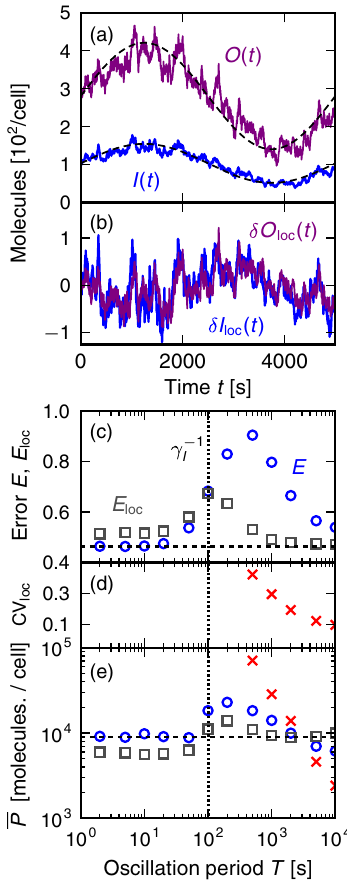
FIG. 5. (a) Sample KMC simulation trajectories for I ð t Þ (solid blue) and O ð t Þ (solid purple) in a Λ ¼ 10 system driven by an oscillatory upstream flux F ð t Þ (see text for parameters). Dashed t Þ and O t Þ . (b) For trajectories in (a), lines are local means I loc ð loc ð t Þ (blue) and δ O t Þ the deviations from local means, δ I loc ð loc ð (purple). (c) – (e) Results calculated from KMC simulations for a system with Λ ¼ 10 and oscillatory F ð t Þ at varying driving periods T . γ − 1 is marked by a vertical dashed line. (c) The I (squares). E is marked by minimum errors E (circles) and E loc WK a horizontal dashed line. (d) The minimum local coefficient of ffiffiffiffiffiffiffiffiffiffiffiffiffiffiffiffiffiffiffiffiffiffiffiffiffiffiffiffiffiffi p ¯ 2 i O variation CV . (e) The mean phosphatase hð δ O loc = loc ¼ loc Þ ¯ P population values at which the minima shown in (c) and (d) are ¯ P achieved ( E , circles; E , squares; CV , crosses). The value loc loc for WK optimality is marked by a horizontal dashed